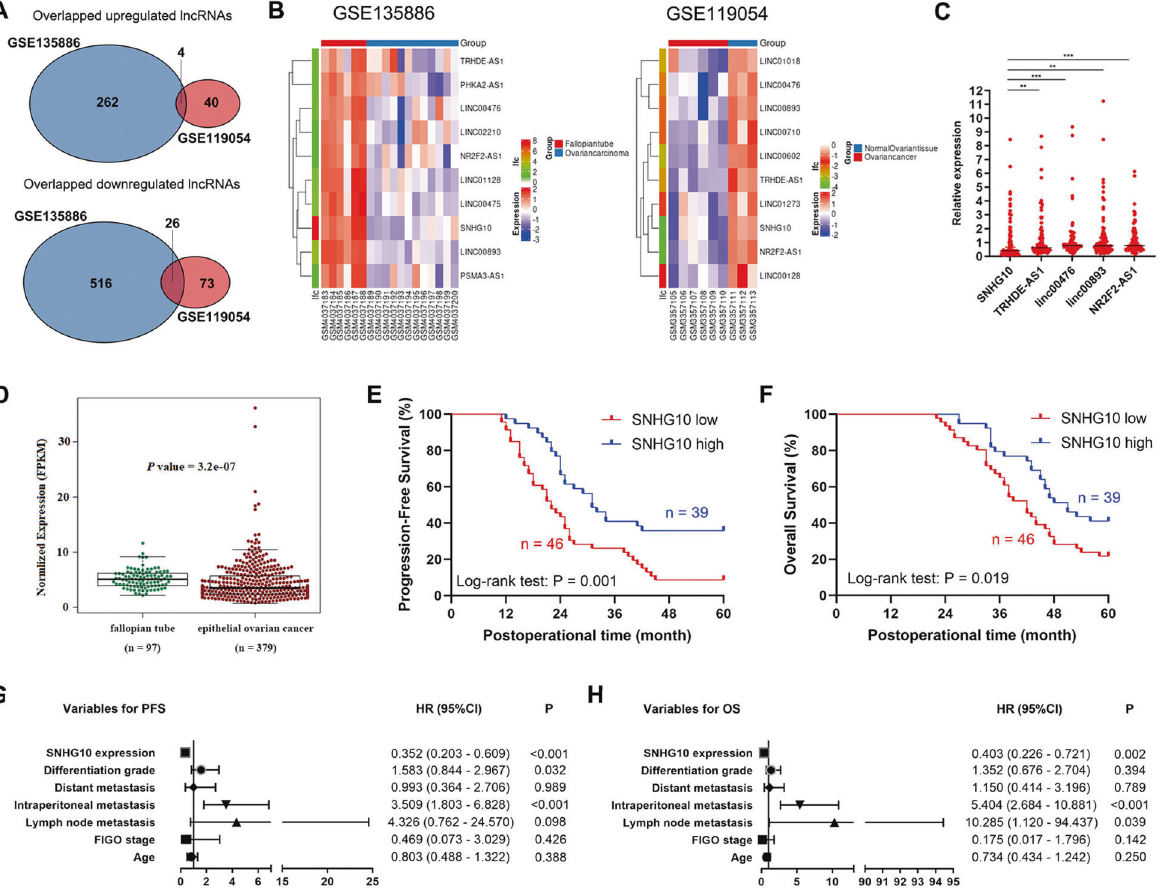
Fig. 1 SNHG10 is downregulated in EOC tissues and positively correlated with prognosis of patients. A Schematic illustrations showing the overlapped lncRNAs in GSE135886 and GSE119054 dataset. B The top 10 downregulated lncRNAs in GEO dataset GSE135886 and GSE119054. C The expressions of the overlapped downregulated lncRNAs in EOC specimens. D SNHG10 exhibited lower expression in EOC tissues ( N = 97), compared to the fallopian tube ( N = 379), by analyzing the TCGA database. E SNHG10 expression was positively correlated with the PFS of EOC patients, analyzed by Kapan – Meier analysis. F SNHG10 expression was positively correlated with the OS of EOC patients, analyzed by Kapan – Meier analysis. G Variables predicting PFS of EOC patients, analyzed by COX proportional hazard progression model. H Variables predicting the OS of EOC patients, analyzed by COX proportional hazard progression model. * P < 0.05, ** P < 0.01, *** P <